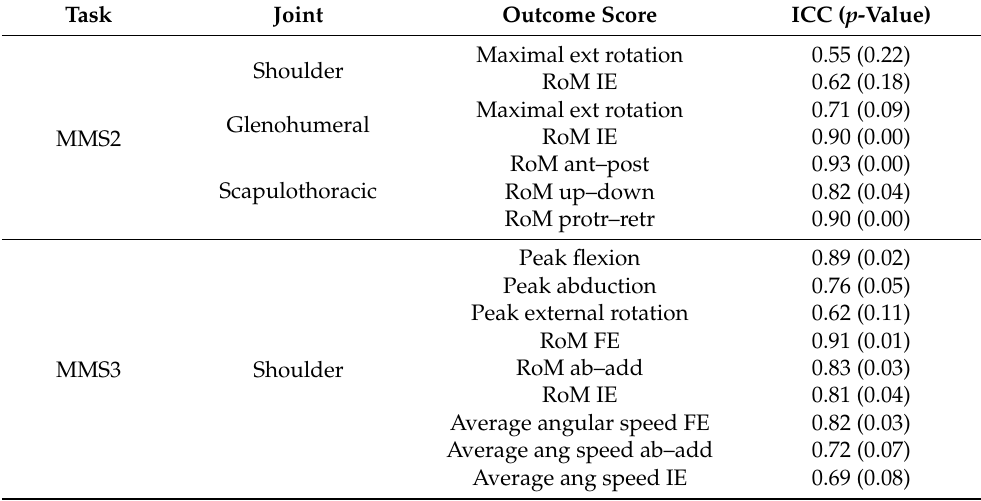
Figure 7. Outcome measures from the assessment of two tasks from the modified Mallet scale (MMS); ( A ) hand to mouth and ( B ) internal rotation. Group mean and standard error of mean are illustrated (BPBI: red left bar, control: blue right bar). ICC from test–retest reliability and p-values from t -tests are shown in the upper right corner of each subplot and are highlighted green for outcome scores with both good test–retest reliability (ICC > 0.75) and a significant group difference ( p < 0.05). Table 3. Interrater reliability for two test leaders assessing BPBI patients in MMS2 global external rotation and MMS3 hand to neck.